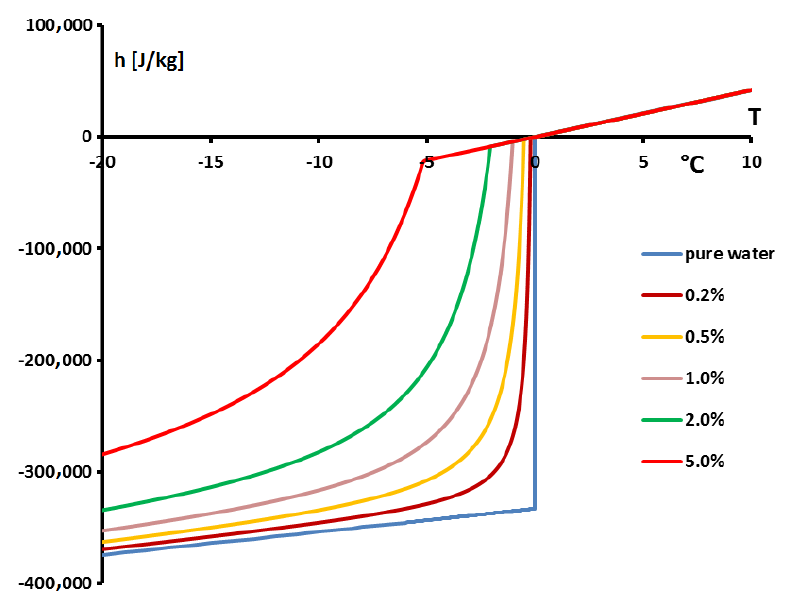
Figure 18. Specific enthalpy for different y 0 (percentage) versus T